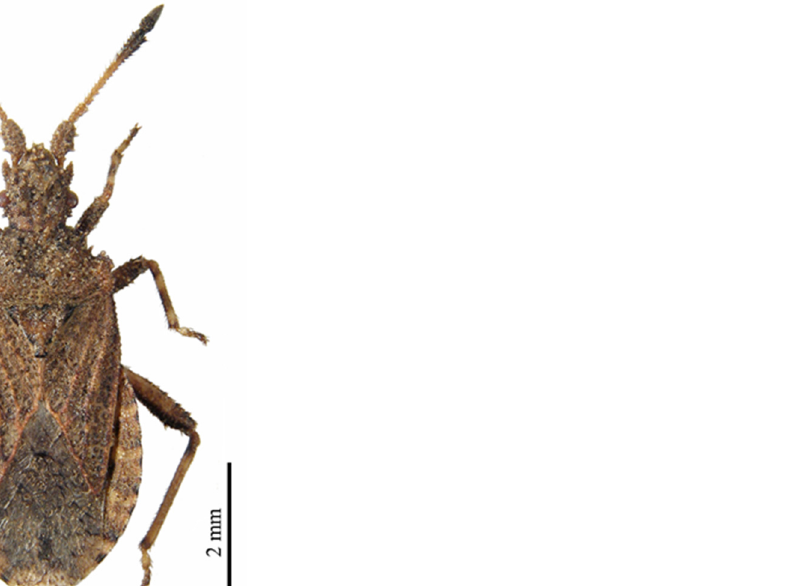
Figure 6. Arenocoris waltlii (Herrich-Schäffer 1834; photo M. Zilioli).